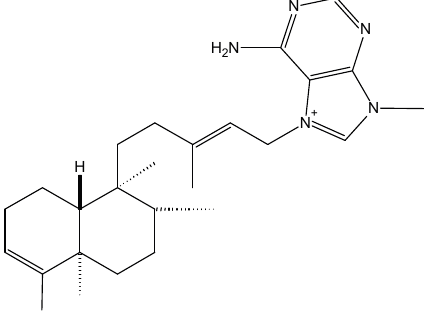
Figure 1. Chemical structure of agelasine B (1).